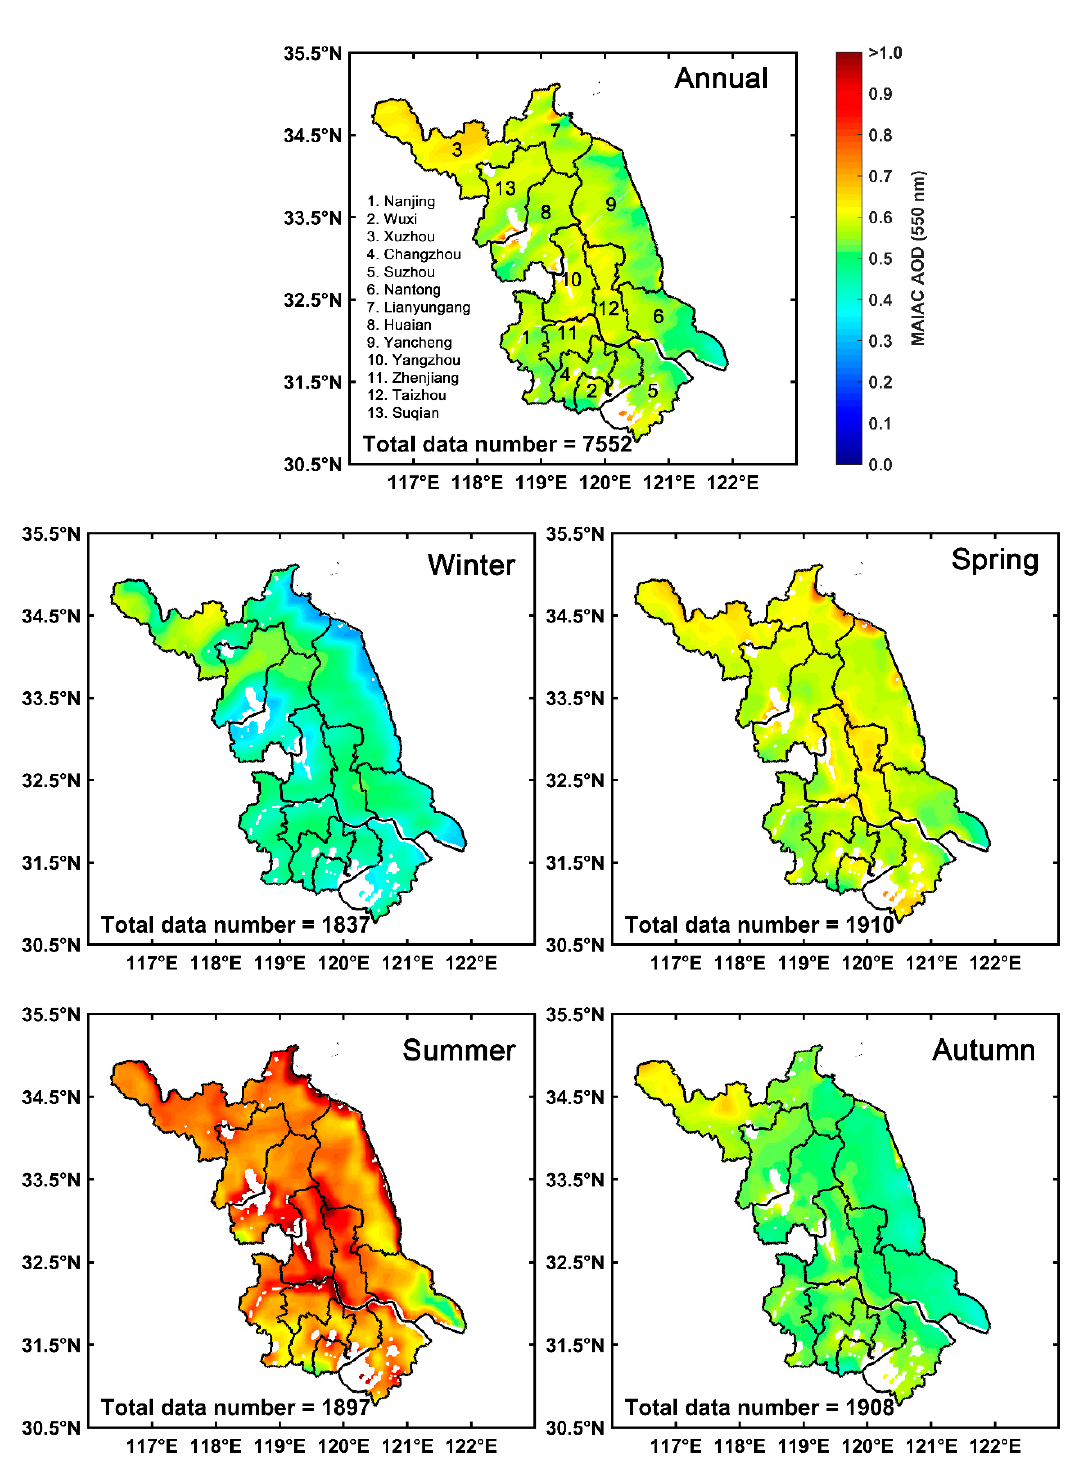
Figure 3. Annual and seasonal spatial distribution of high-resolution MODIS MAIAC AOD over Jiangsu Province from 2000 to 2020.